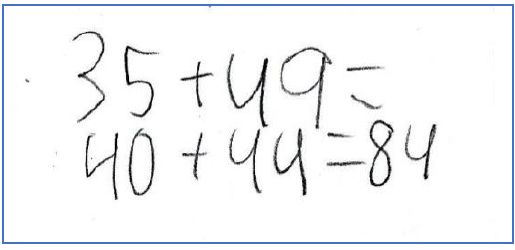
Figure 35. Work out 35 + 49.